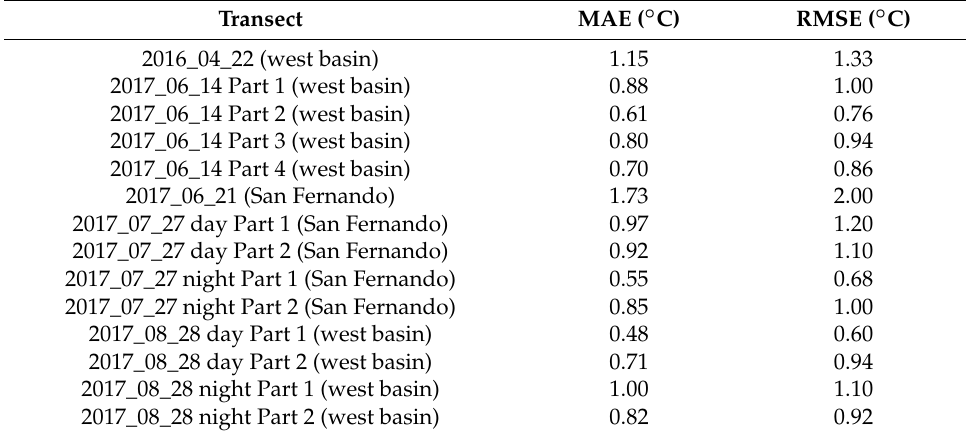
Table 2. Model performance metrics against observational mobile-transect temperature.